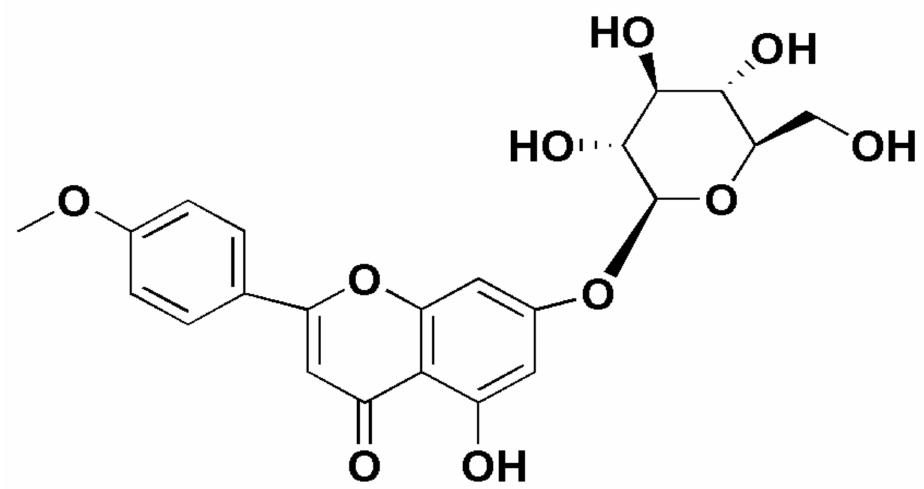
Figure 1. Chemical structure of